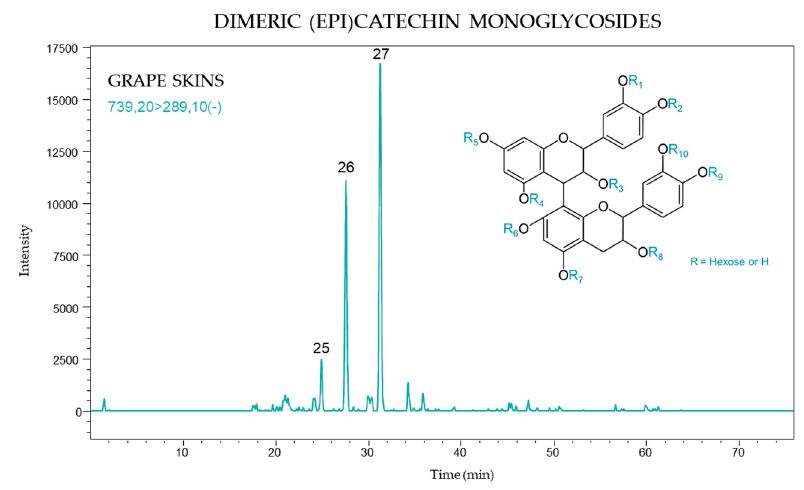
Figure 7. Dimeric (epi)catechin monoglycoside (DMG) profile of skins from Vitis vinifera grapes using MRM [739 → 289].